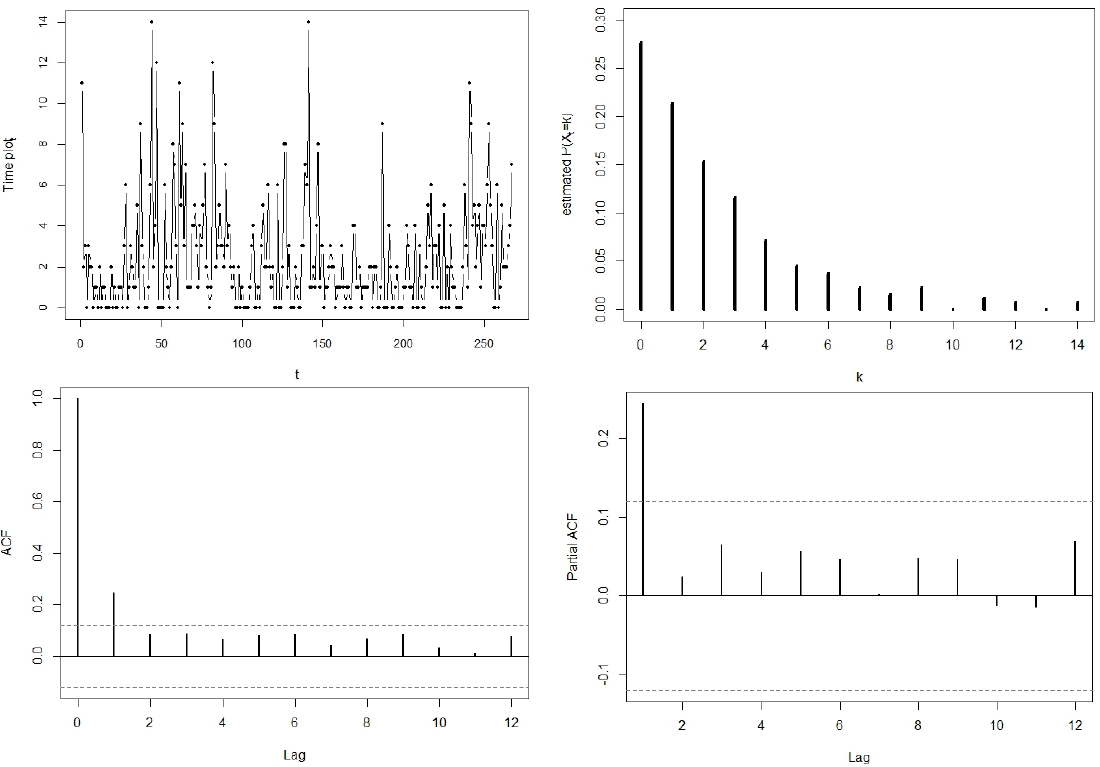
Figure 5. The time plot, observed marginal distribution, ACF, and PACF of the downloads dataset.